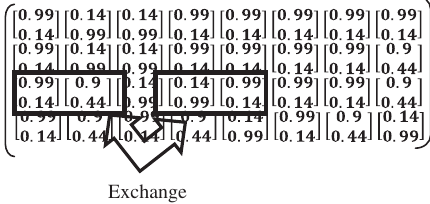
Figure 10. Mutation Operators: Register of Qubit Mutation.